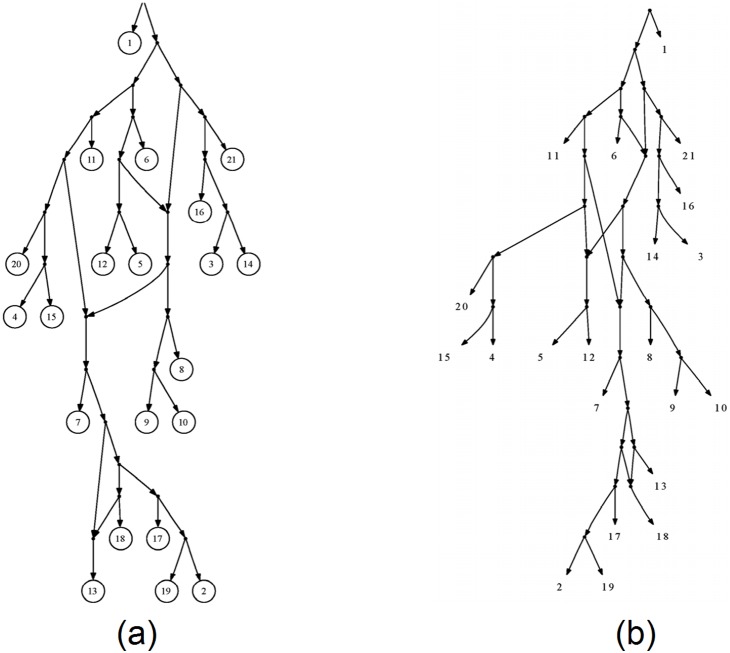
Resulting networks from Yeast triplets. (a) LEVEL2 algorithm result. (b) TripNet algorithm result.